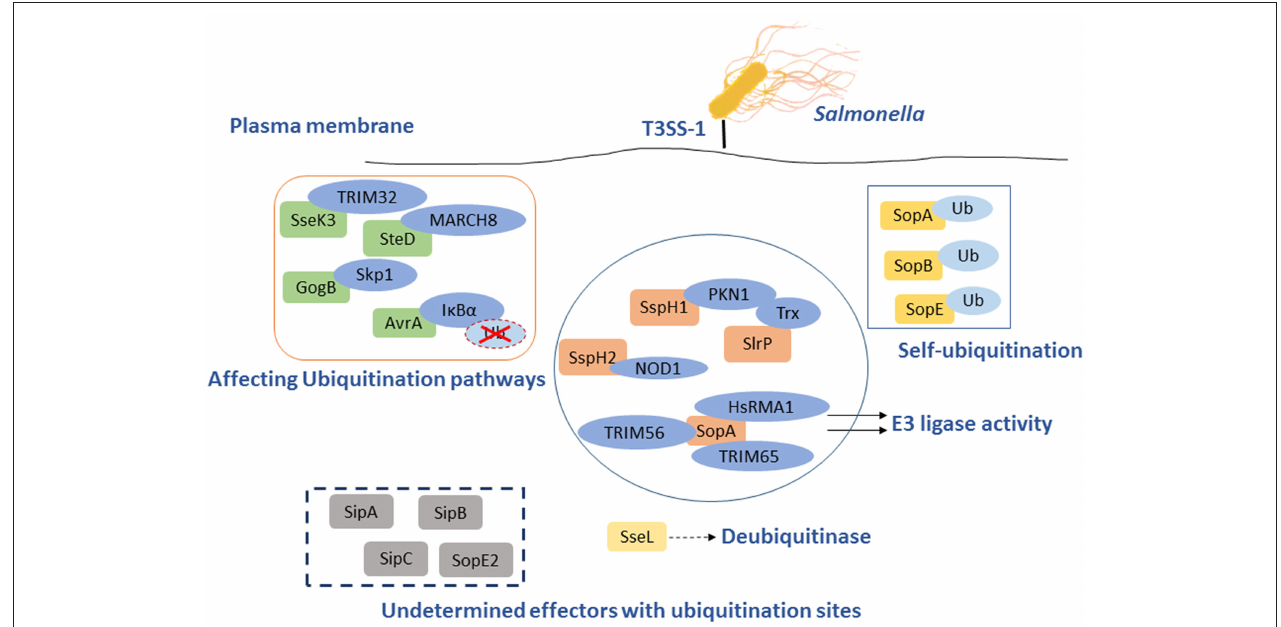
FIGURE 2 | Salmonella T3SS effector proteins that interact with the eukaryotic ubiquitin system. Some effectors act as E3 ligase interacting with host proteins to inhibit NF- κ B pathways, such as SopA, SlrP, SspH1, and SspH2. The others serve as DUB to play a role on the responses to infection through Ub pathway, SseL is the best example. GogB and AvrA are effectors that interact with the host Ub pathways following diversity mechanism to impact the immune system. Ssek and SteD can affect host immune responses by interacting with E3 Ub ligase TRIM32 and MARCH8, respectively. Furthermore, SopB, SopA, and SopE could also be self-ubiquitinated to influence the antimicrobial process. However, several effectors with ubiquitination sites remain to be